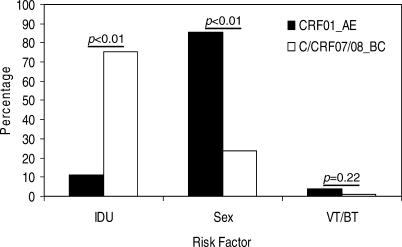
The Distinct Distribution of Two Major HIV-1 Subtypes among Different Risk Groups in YunnanThe risk factors include sexual contact (Sex), injection drug use (IDU), vertical transmission (VT), and blood transfusion (BT). The p-values are based on analysis using the chi-square test of association or Fisher's exact probability test.